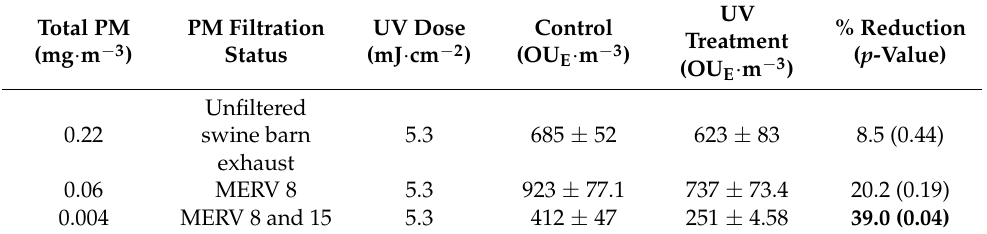
Table 10. Performance of UV-A photocatalysis in mitigating odor under different PM